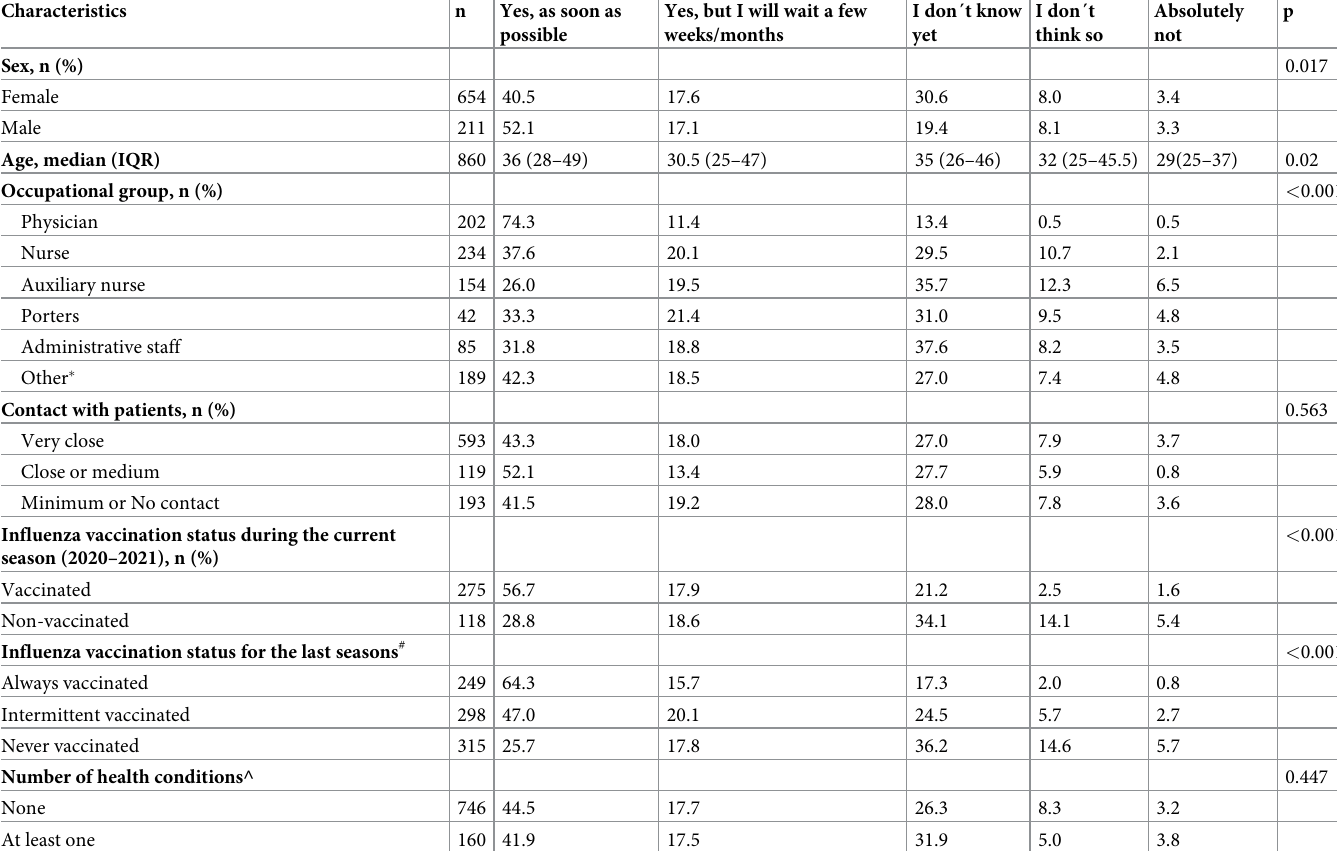
Table 2. Attitudes towards receiving the COVID-19 vaccine by demographic, occupational, and clinical